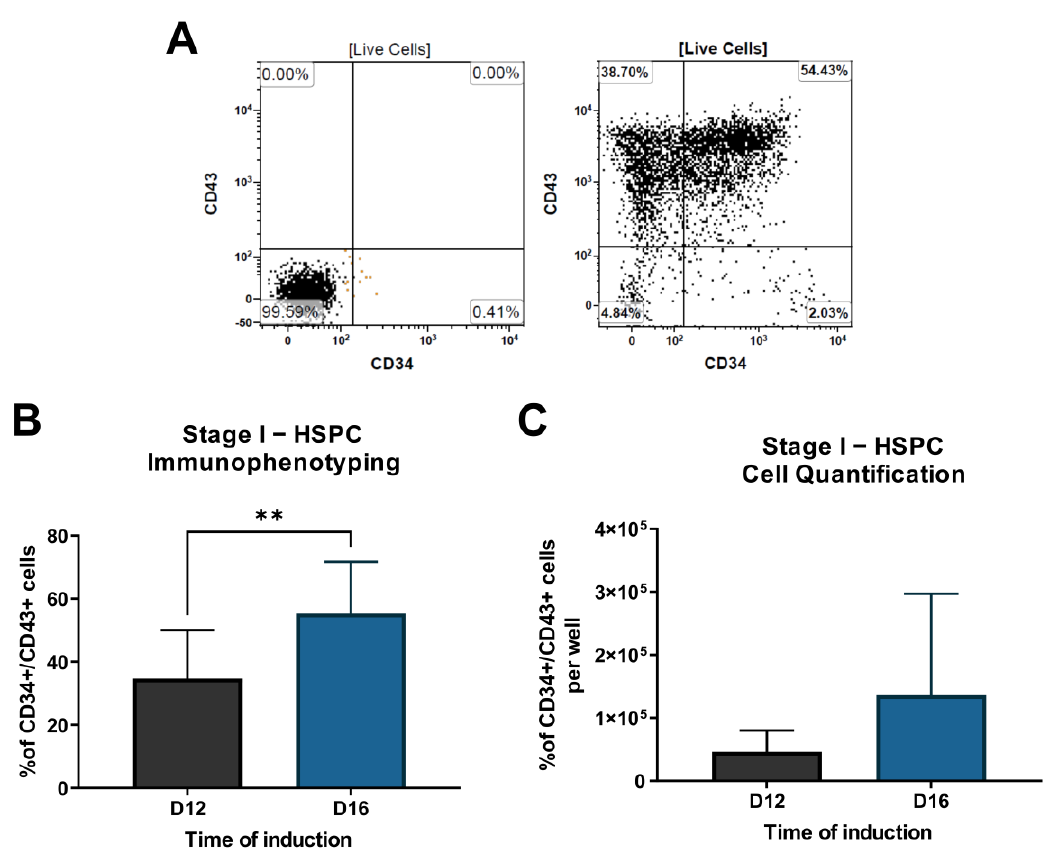
Figure 3. Representative flow cytometry dot plots analysis of CD34 and CD43 markers for HSPC of D12 and D16 samples (left: isotype controls; right: specific antibodies) ( A ). Percentage of cells ( B ) and cell quantification per well ( C ) of CD34 + /CD43 + subpopulation at D12 and D16. ** p = 0.0031.